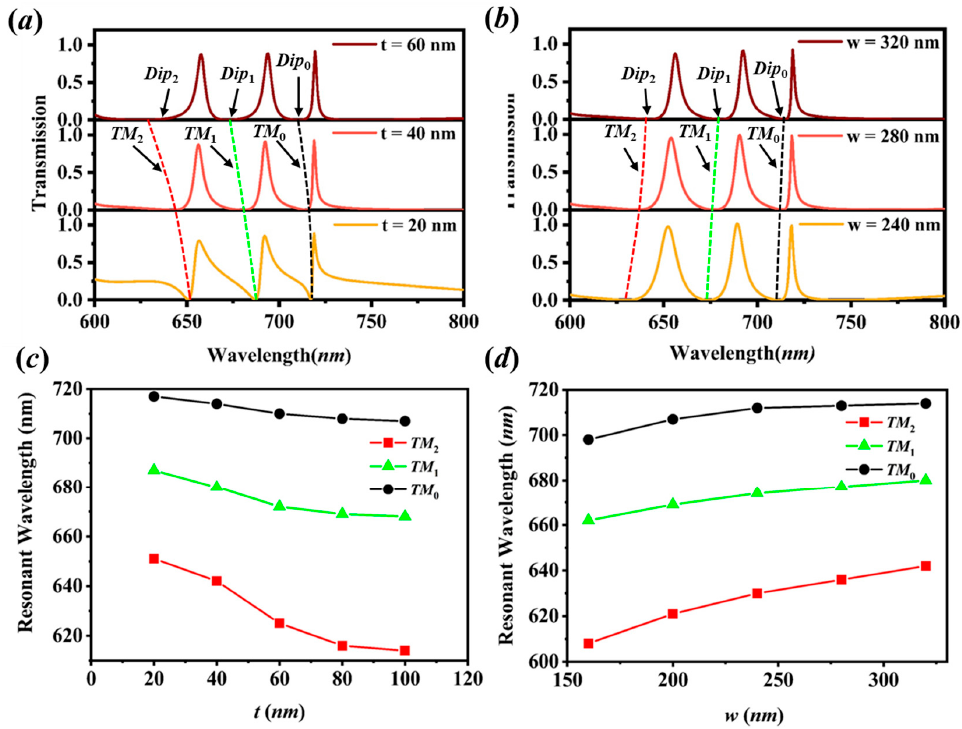
Figure 4. ( a ) and ( b ) Transmission spectra of the proposed structure ( Figure 4. ( a , b ) Transmission spectra of the proposed structure ( N = 3, p = 400 nm, t L = 100 nm, t H = 200 nm, n L = 1.5, n H = 2) for various t with w = 320 nm and various w with; ( c , d ) dependences of resonant wavelengths of the suppressed hybrid SP waveguiding modes noted as TM 0 , TM 1 and TM 2 on t and w